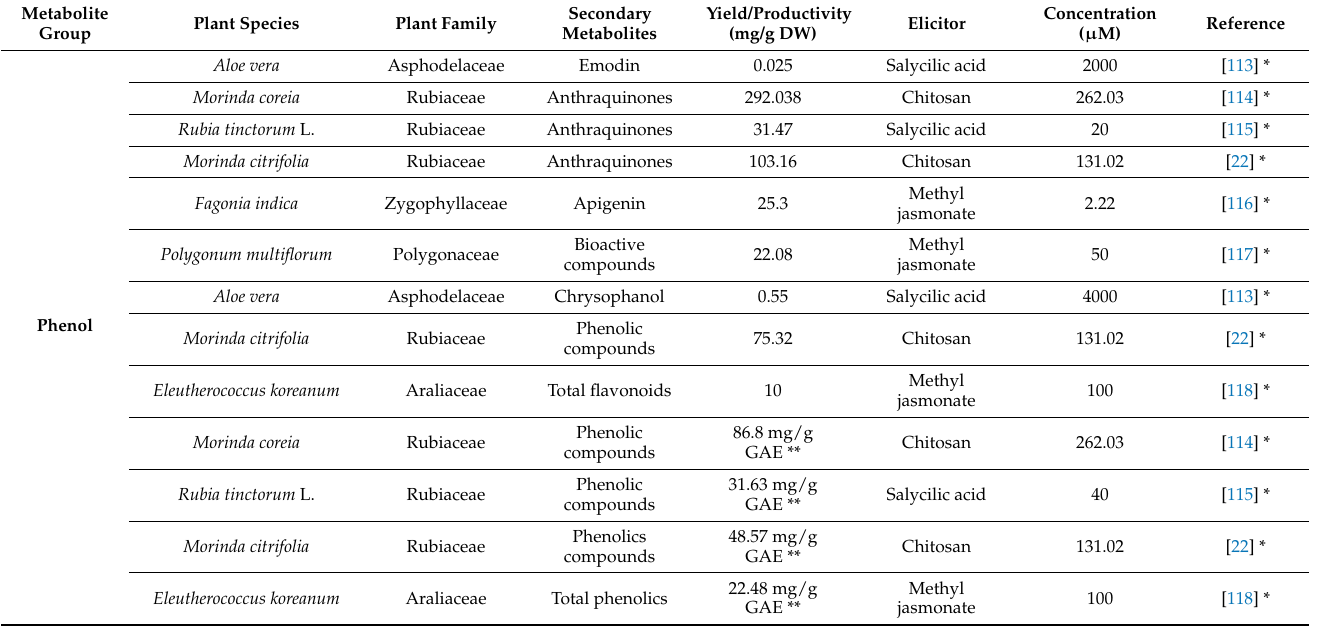
Table 2. Elicitation in adventitious roots from 2010 to